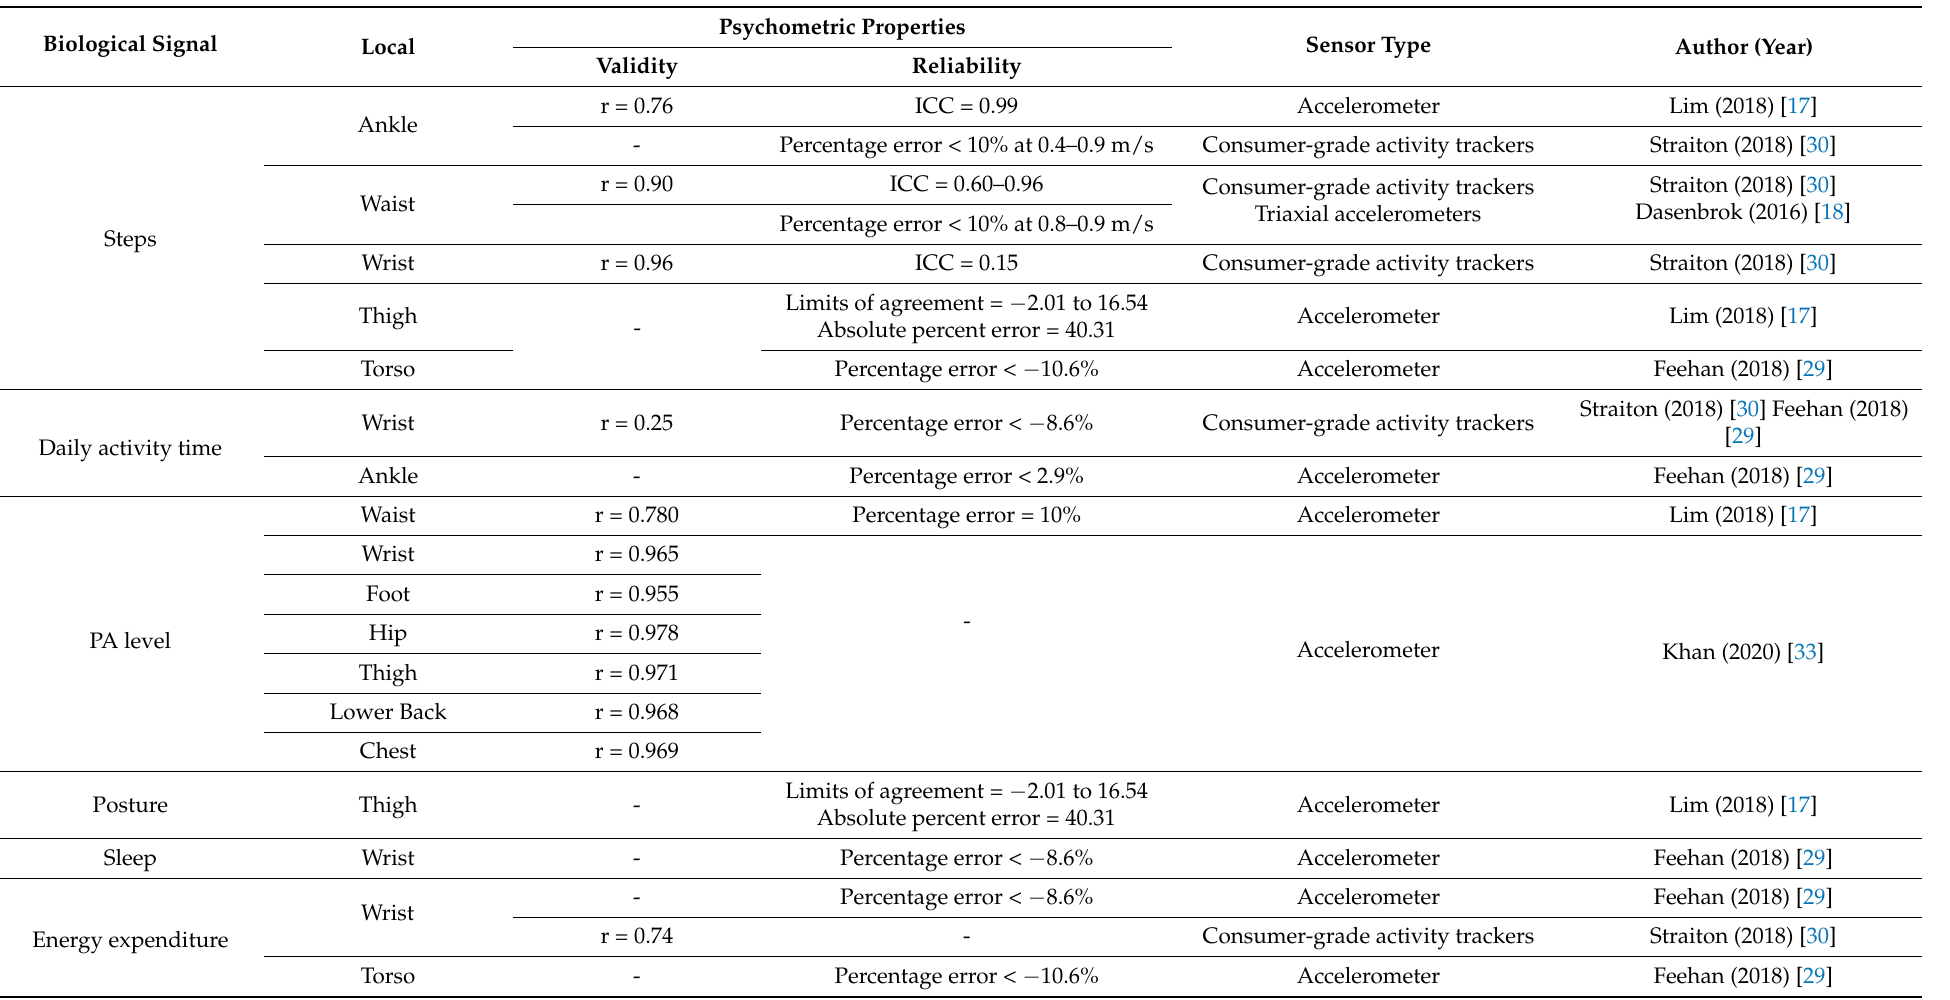
Table 6. Psychometric properties of the health-related biological signals—device—sensor—device